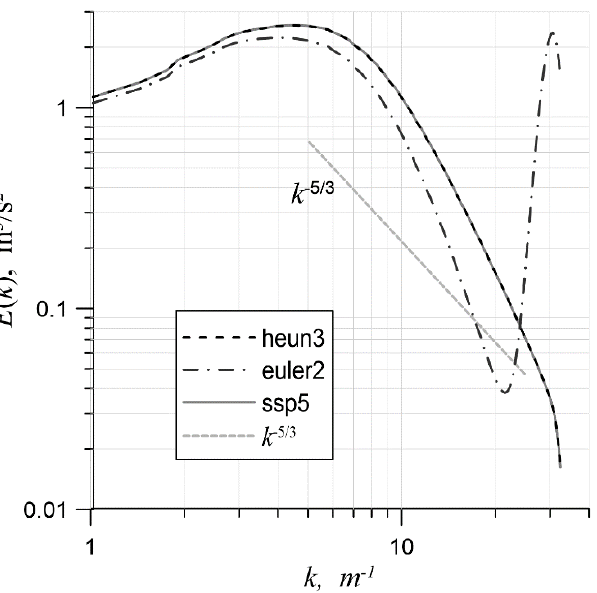
Figure 3. The turbulent-energy spectrum for three different time schemes on the mesh with 64 3 cells; 1 C = . DES 2